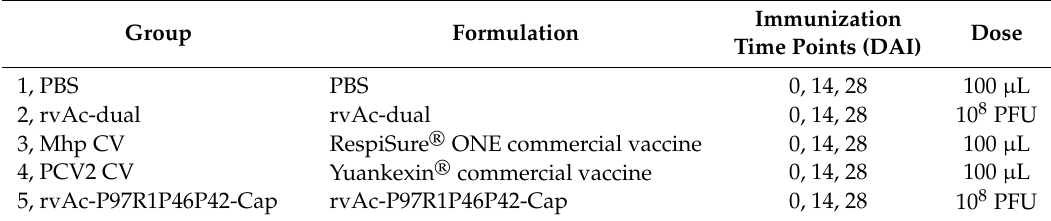
Table 2. Mouse vaccination